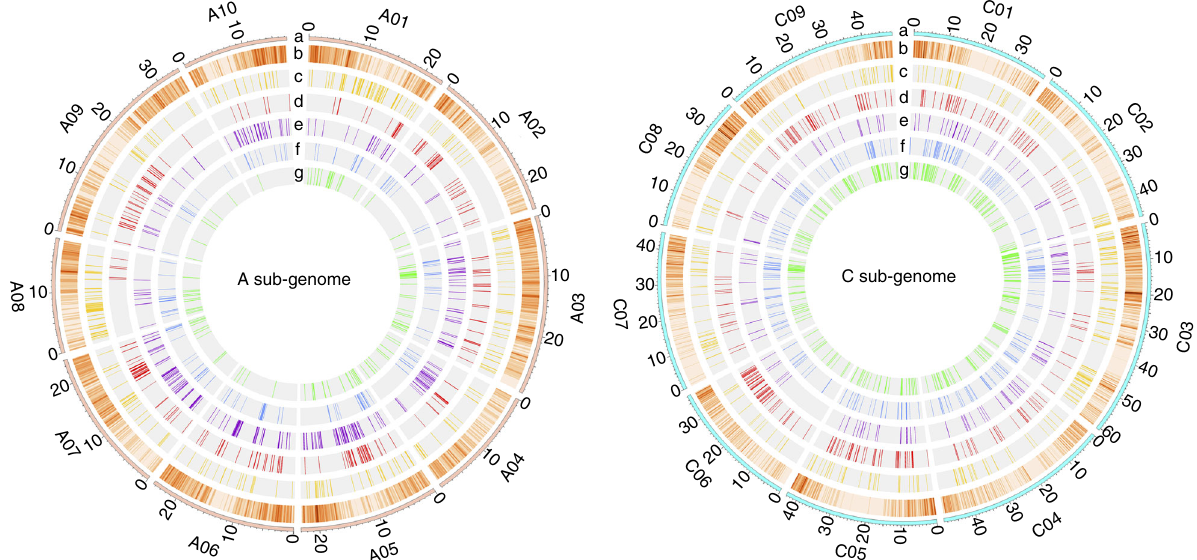
Fig. 4 Selective sweep regions among different genetic clusters. Left panel is A sub-genome and right panel is C sub-genome, each with rings labeled a – g . a A and C chromosomes of B. napus . b SNP density within a 200 kb window across each chromosome. c – g selective sweep regions. Colors indicate different genetic clusters. Red: S; Orange: WEsA; Green: WeA; Purple: SK; Blue: